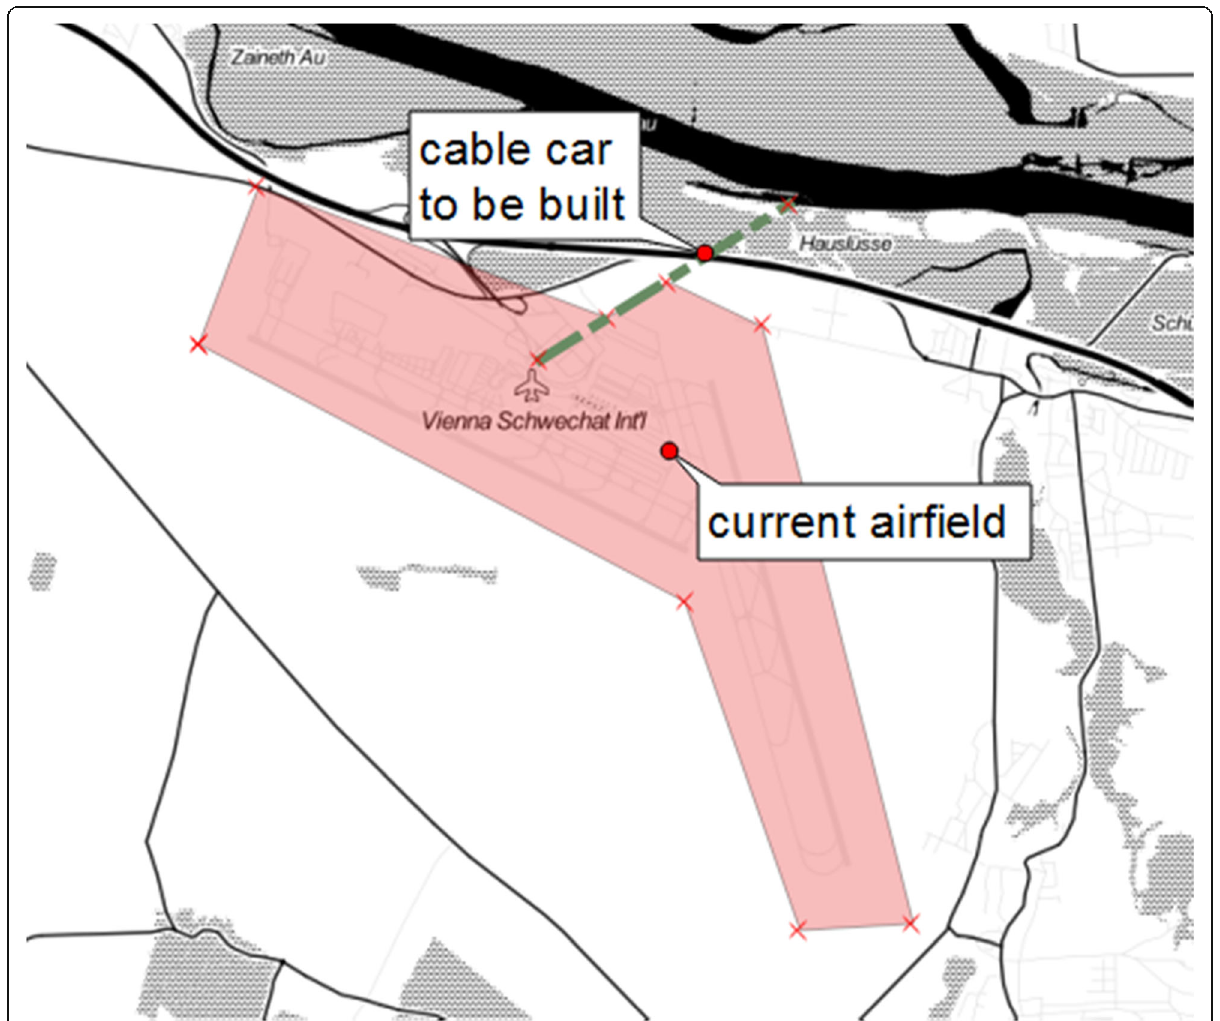
Fig. 4 Cable car line for the connection with the riverbank